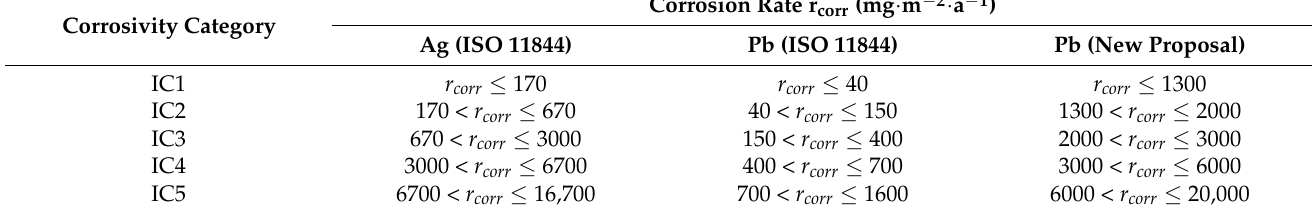
Table 2. Corrosivity categories of indoor atmosphere based on corrosion rate measurements by mass loss determination of standard specimens according to ISO 11844 and new proposal based on results of this